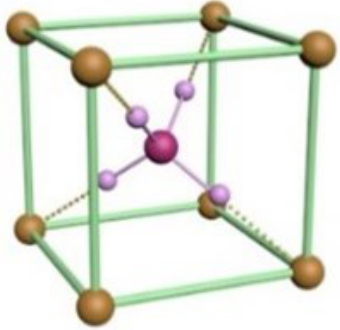
Figure 6. The schematic representation of the elementary unit cell of ammonium